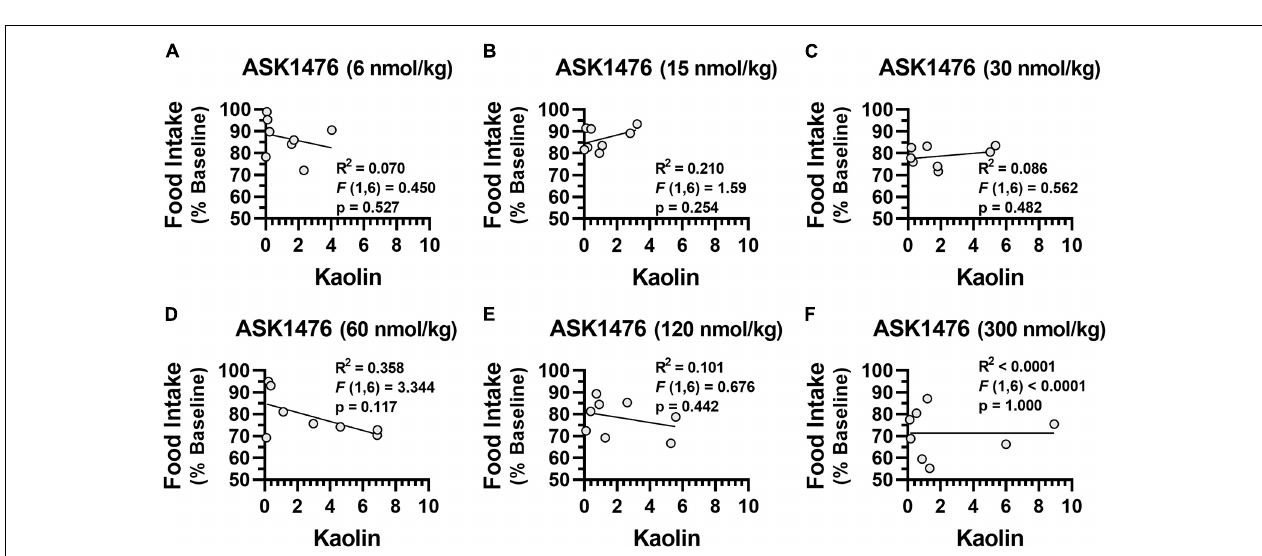
FIGURE 5 | Relationship between kaolin consumption and food intake There was no significant association between kaolin consumption and baseline normalized food intake due to ASK1476 dosing at 6 nmol/kg (A) , 15 nmol/kg (B) , 30 nmol/kg (C) , 60 nmol/kg (D) , 120 nmol/kg (E) , and 300 nmol/kg (F) .